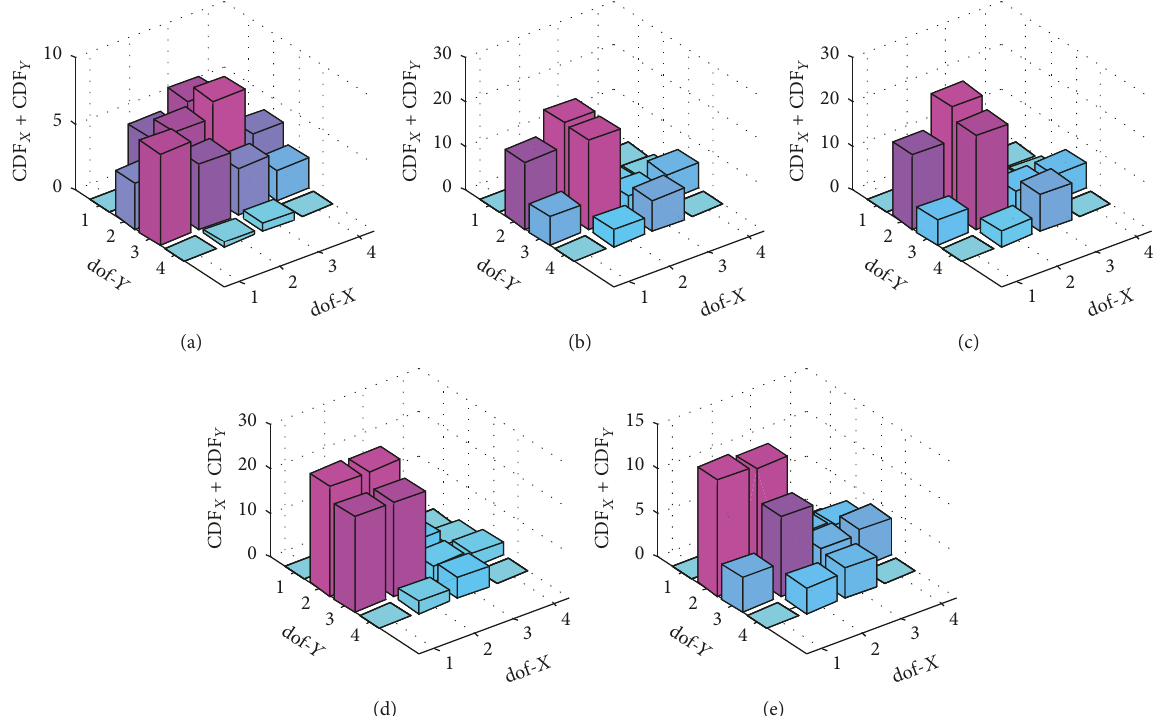
Figure 14: CDF calculated the modal data obtained from FDD Method. (a) DS0 versus DS1, (b) DS0 versus DS2, (c) DS0 versus DS3, (d) DS0 versus DS4, and (e) DS0 versus